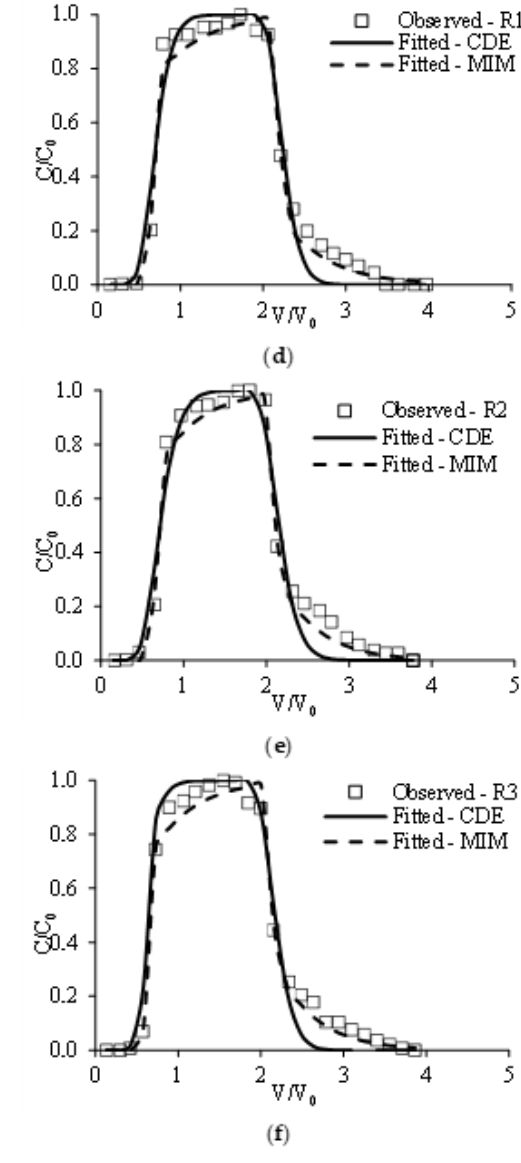
Figure 3. KBr observed and fitted breakthrough curves (BTCs) for the CDE and MIM models two-region models CM1 ( a – c ) and CM2 ( d – f ). Table 5. Estimated values of parameters, determination coefficient R 2 , and statistical criteria for the CDE model for KBr transfer in the soils CM1 and CM2 for the tracer (KBr).